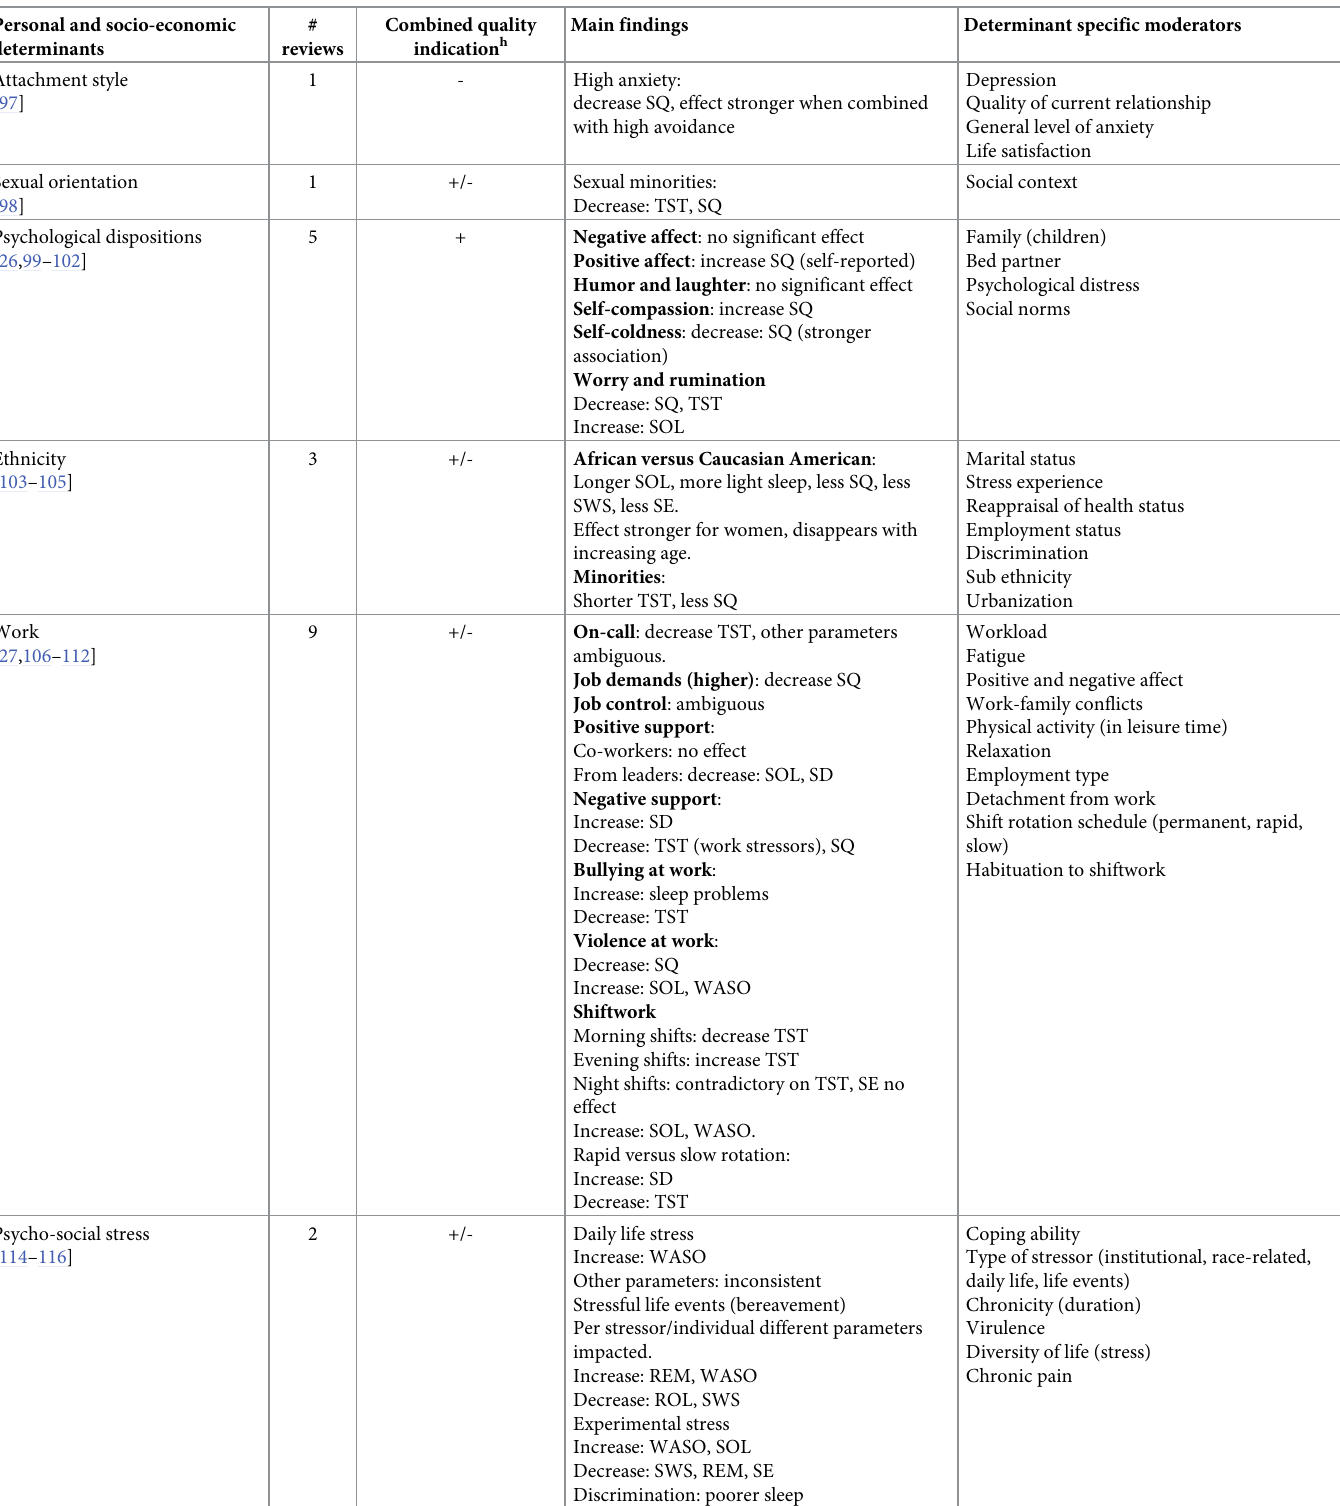
Table 6. Overview of personal and socio-economic determinants of